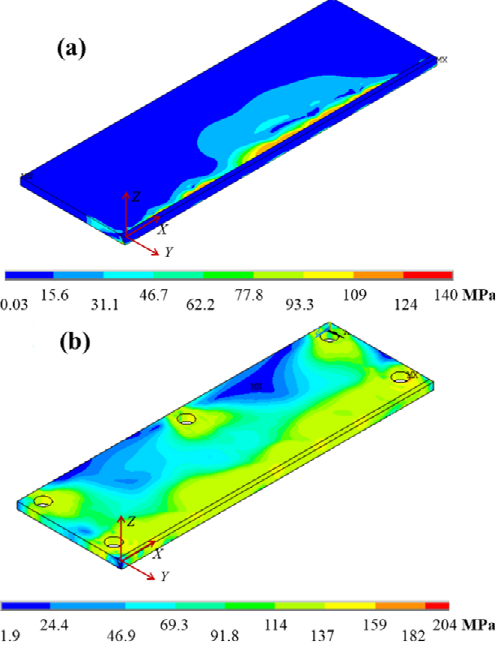
Figure 16. Von Mises stress distribution: ( a ) welded plates without restriction and ( b ) welded plates restricted by bolts.